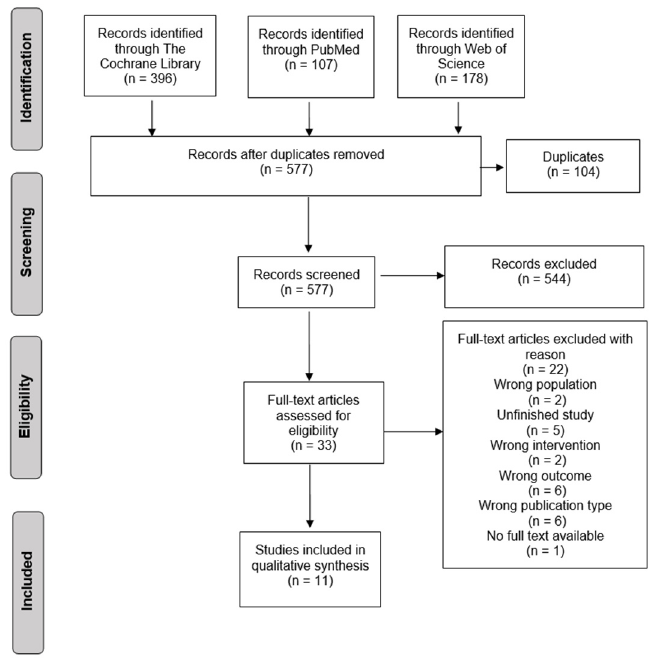
Figure 1. Flow diagram of literature search and selection process.